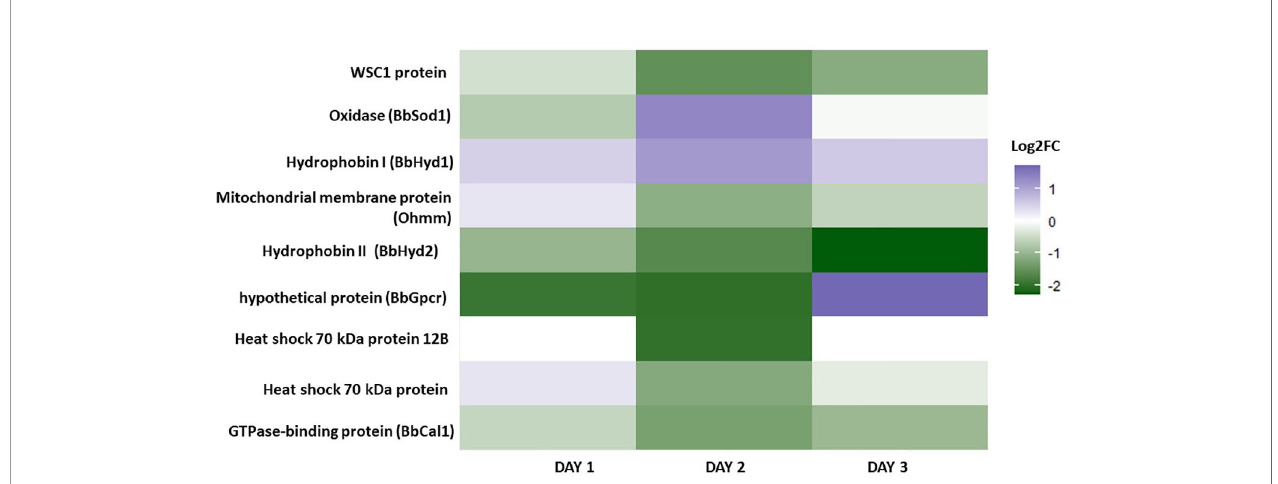
FIGURE 7 | Heatmap depicting the gene expression of nine genes associated with osmotic stress in B. bassiana blastospores grown in liquid cultures supplemented with 20% vs. 10% glucose on days 1, 2, and 3 of fermentation (log2-FC >1 or < -1 in at least one of culture days) (see also Supplemental Table S4